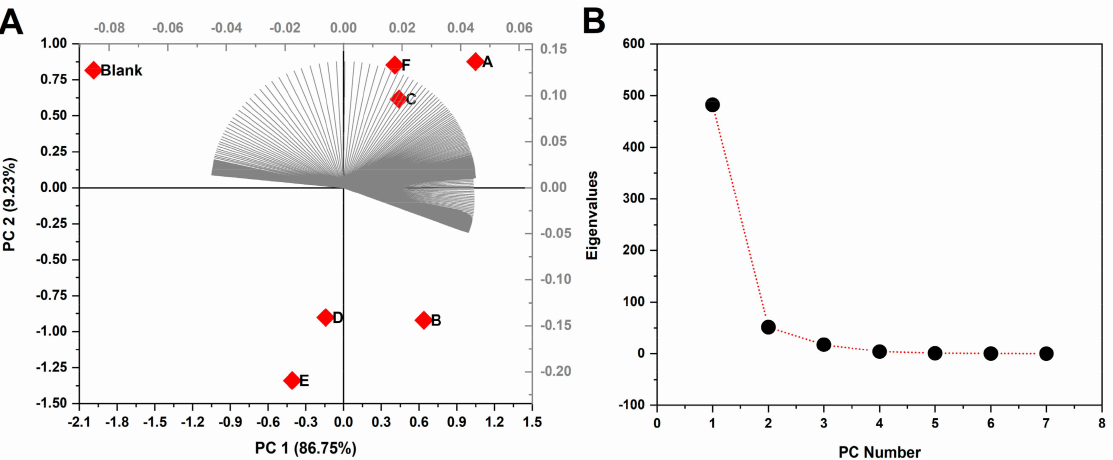
Figure 3. ( A ) PCA biplot of the electric current of the first CV scan of each of the samples (label variables in red). The amount of variance explained by each PC is therein informed in percentage, and the eigenvectors of the discrete electric current values is therein represented in gray. ( B ) Plot of the eigenvalues versus PC number, which was used to refine the